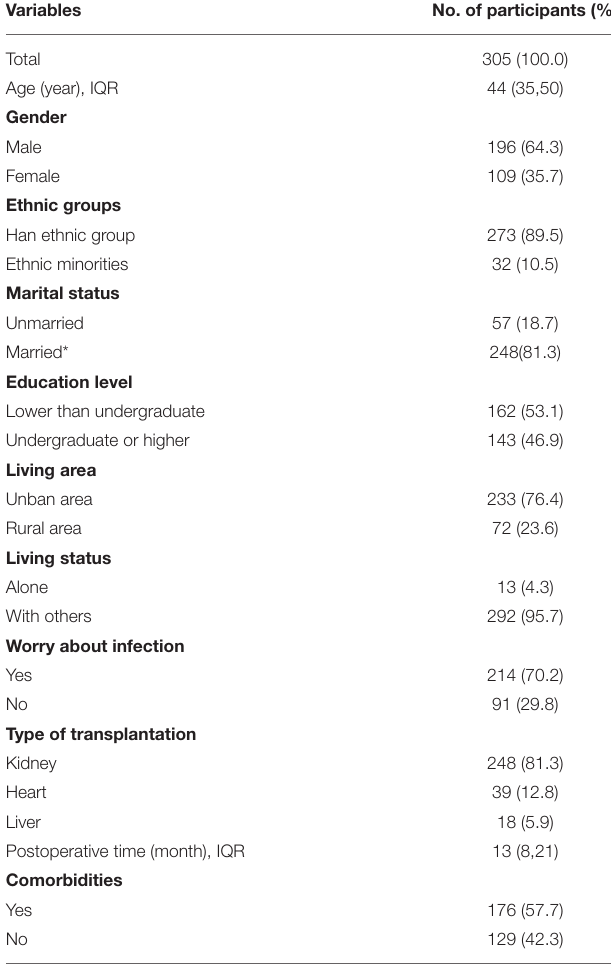
TABLE 1 | Characteristics of organ transplant